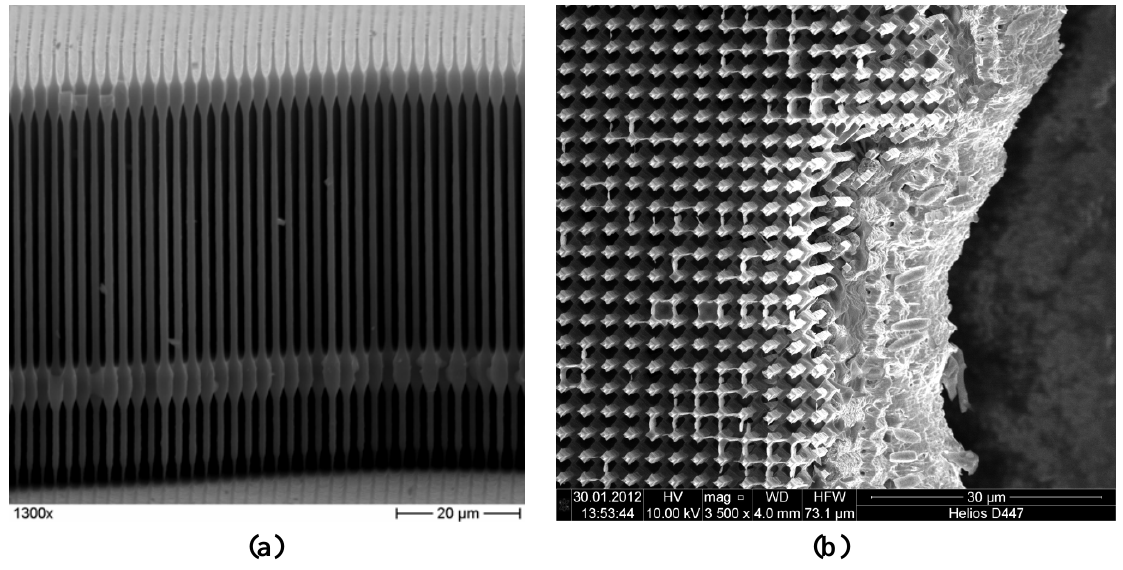
Figure 2. ( a ) Silicon microwire array of the anodes. The wires are 70 µm long and have 1 µm of diameter. The wider parts are stabilizing planes; ( b ) Top view of a finished anode. The bottom 10 µm of the wires are embedded in Cu (visible at the right).